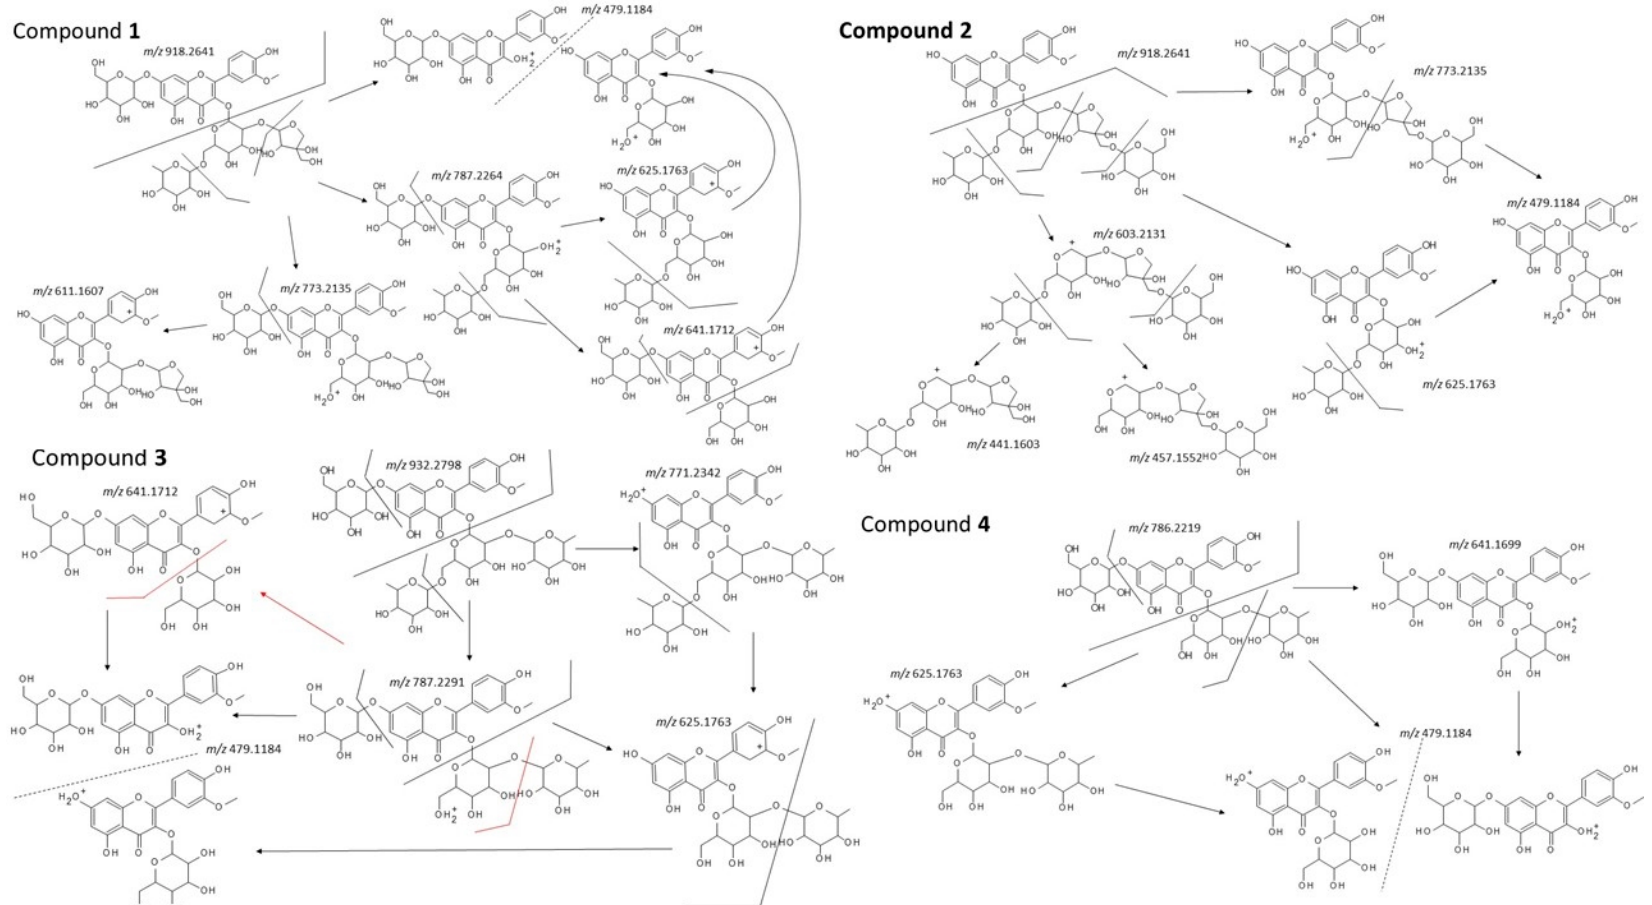
Figure 4. A fragmentation pattern of flavonoid glycosides 1 – 4 (shown m/z are calculated values according to molecular formulas of the ions).